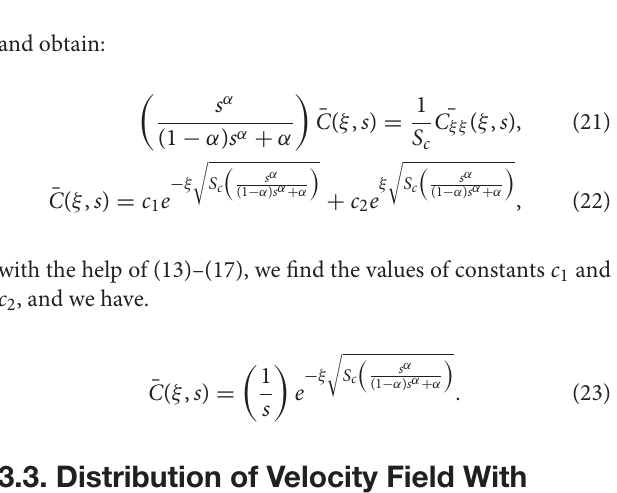
2, α 0.5, P reff 0.1, G m 0.75, M 0.9, and S c = = = = =